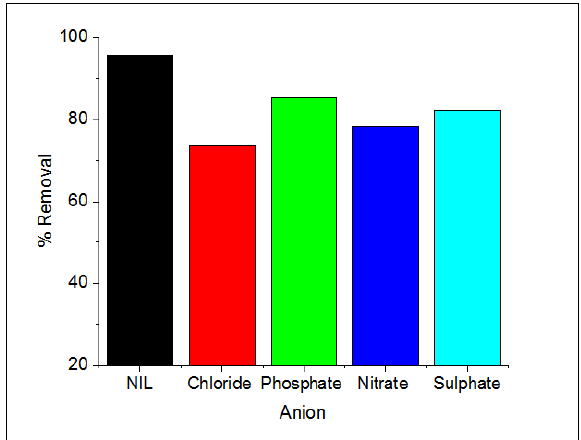
Figure 8. Effect of diverse ions.